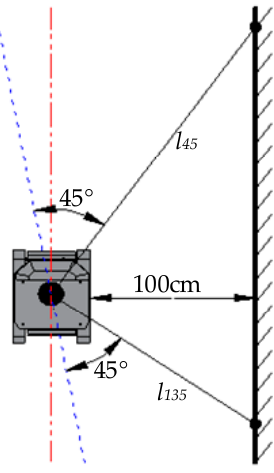
Figure 4. Calibration of the LiDAR’s installed location.